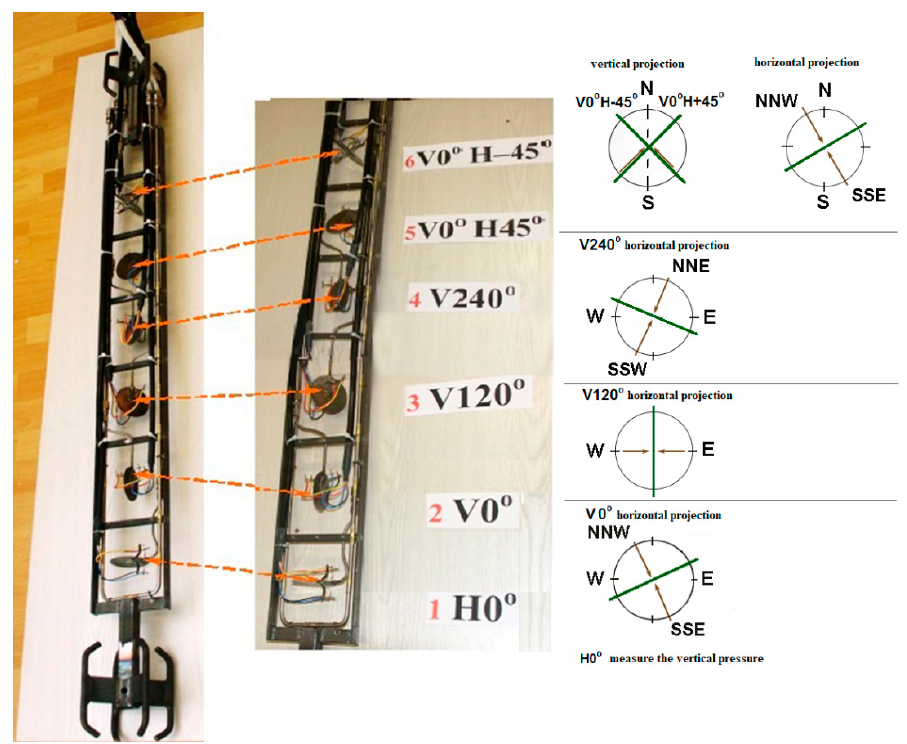
Figure 7. The AWID monitoring system equipped with six pads to measure the pressure in the presented directions.